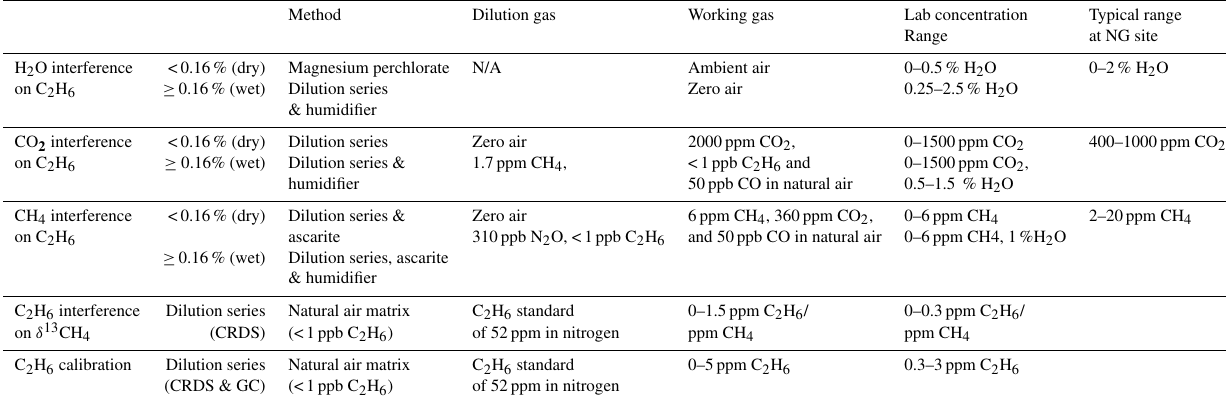
Table 1. Description of the gas mixtures used to determine the cross-sensitivities of the interference of CH 4 , H 2 O and CO 2 on C 2 H 6 and the interference of C 2 H 6 on δ 13 CH 4 . The respective ranges spanned during laboratory tests, and the typical range at a natural gas site are noted on the right-hand